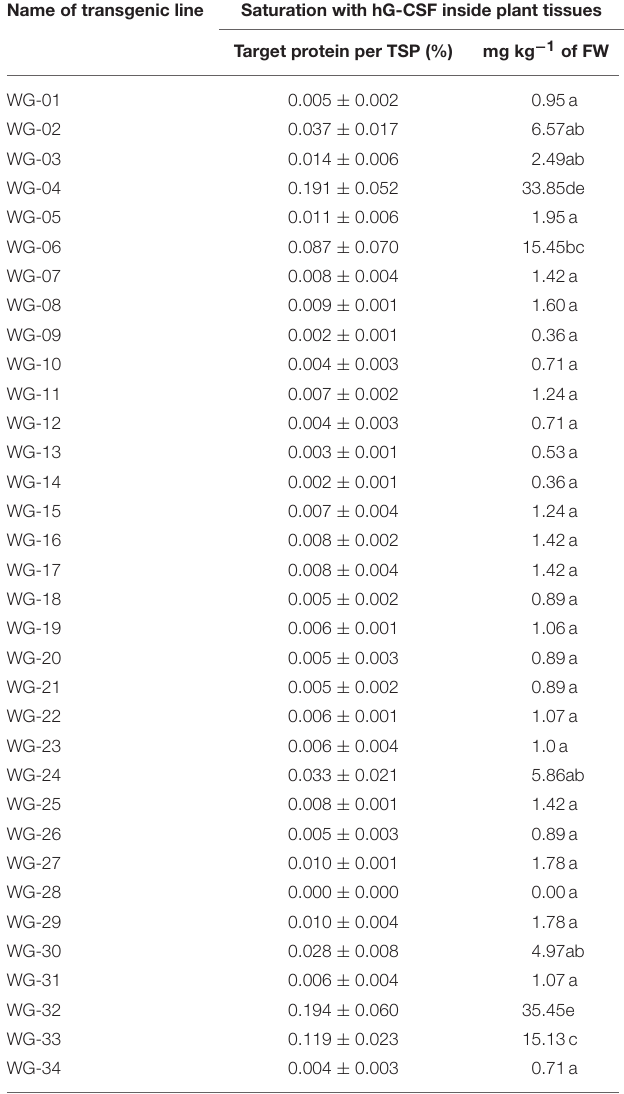
TABLE 1 | Quantitative indicators of hG-CSF expressed in W.arrhiza transgenic